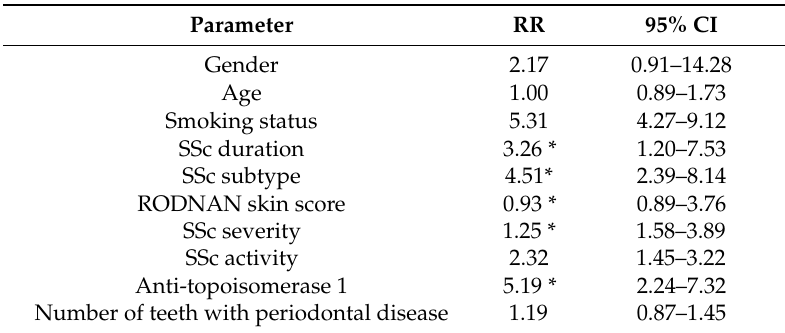
Table 4. Correlations between the number of teeth with PDL space widening and number of teeth with periodontal